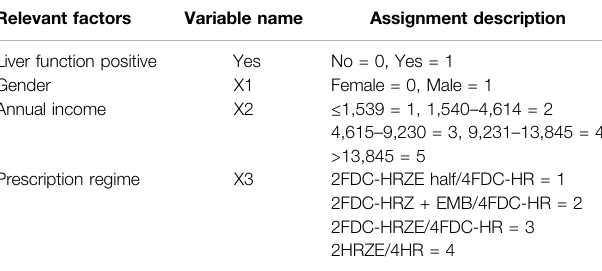
TABLE 6 | Independent variable and dependent variable